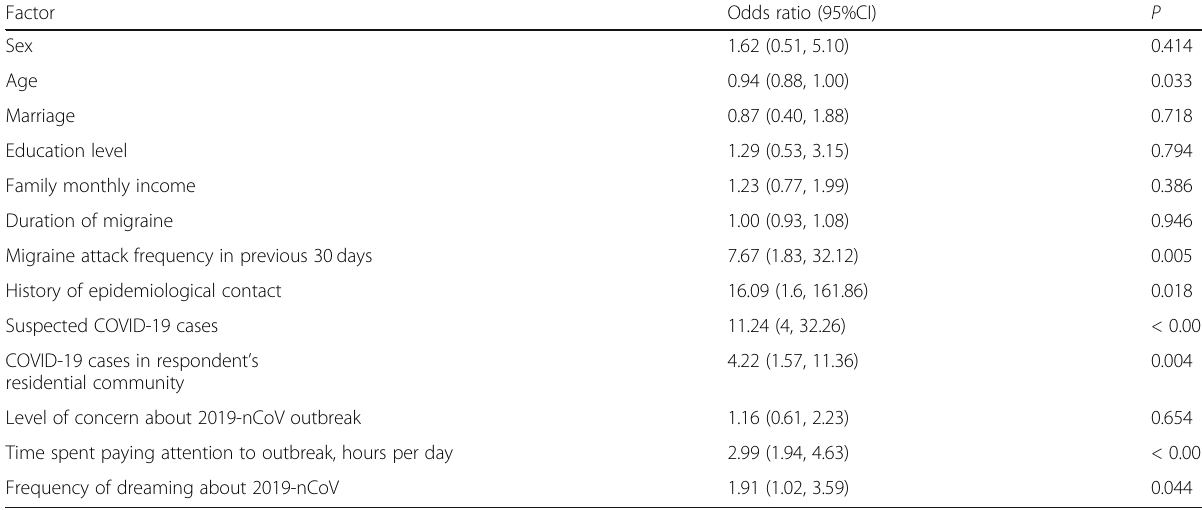
Table 3 Exploration of factors associated with severe psychological distress (K6 score > 12) among migraine patients Factor